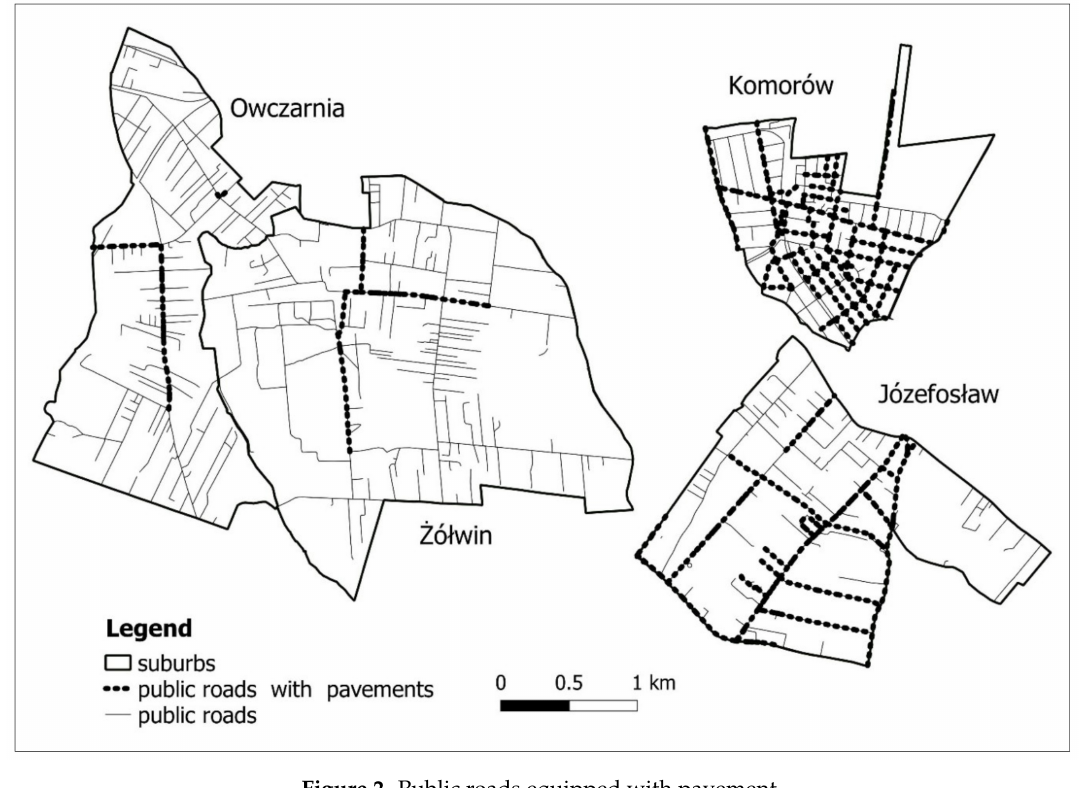
Figure 2. Public roads equipped with pavement.